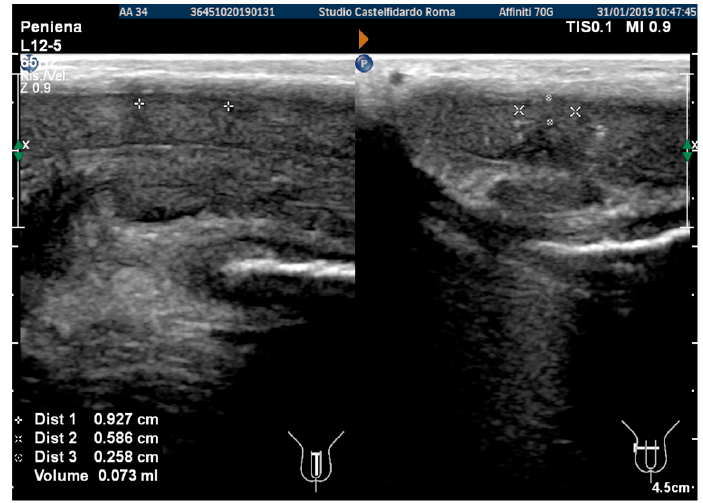
Figure 7. Ultrasonography of the penis after the 2nd therapy cycle (longitudinal and axial views).